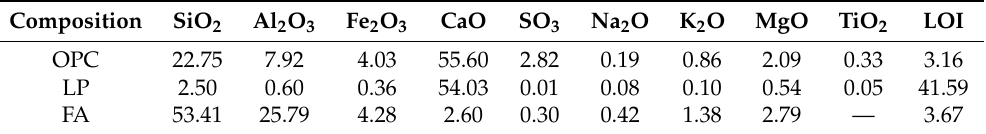
Table 1. Chemical compositions of the ordinary Portland cement (OPC), fly ash (FA), and limestone powder (LP) (mass %).